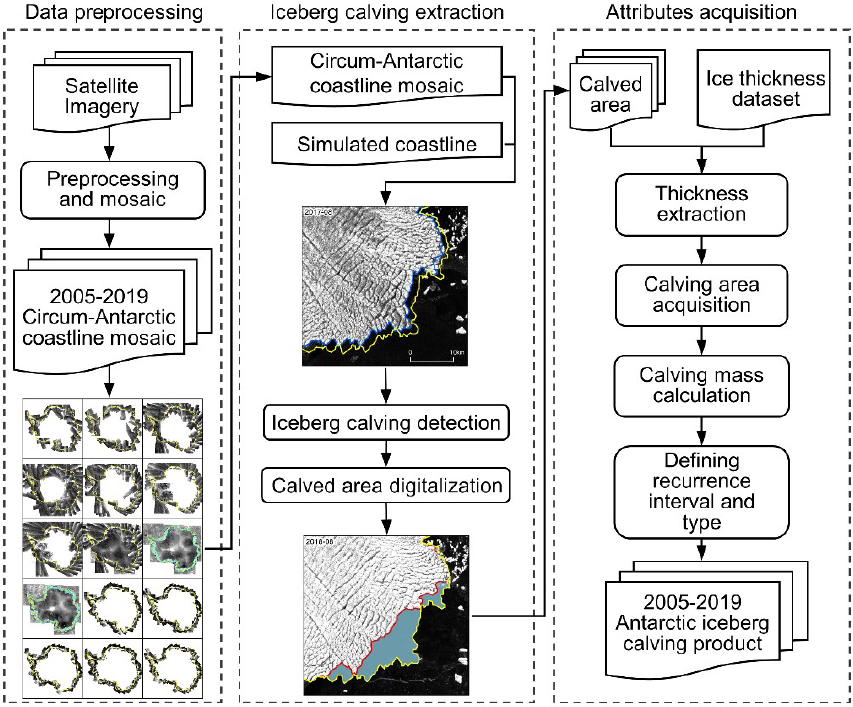
Figure 1. Outline of our methodology. Satellite images are preprocessed to obtain the annual mosaic of the Antarctic coastline. Based on the circum-Antarctic coastline mosaic and corresponding simulated coastline, we extracted calved areas. We then acquired attributes such as thickness, area, volume, mass, and recurrence interval to produce an annual iceberg calving product for the Antarctic ice